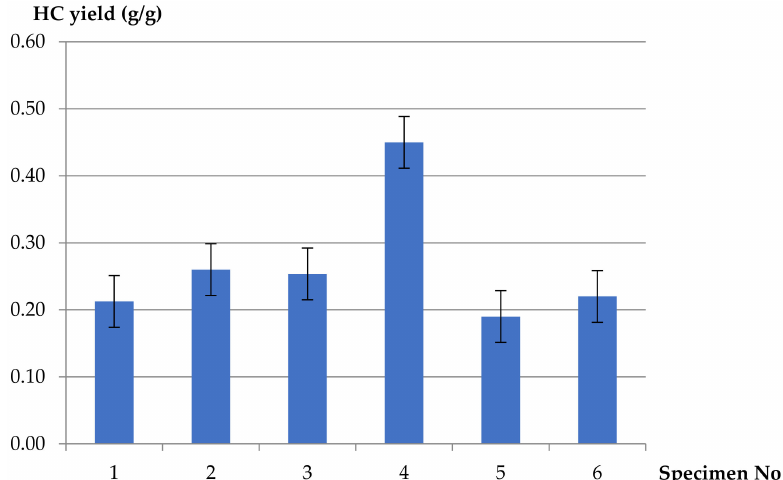
Figure 6. Hydrocarbon yields (mass loss basis) for H07V-U cable, pure PVC and pure LDPE polymers at di ff erent ventilation conditions.